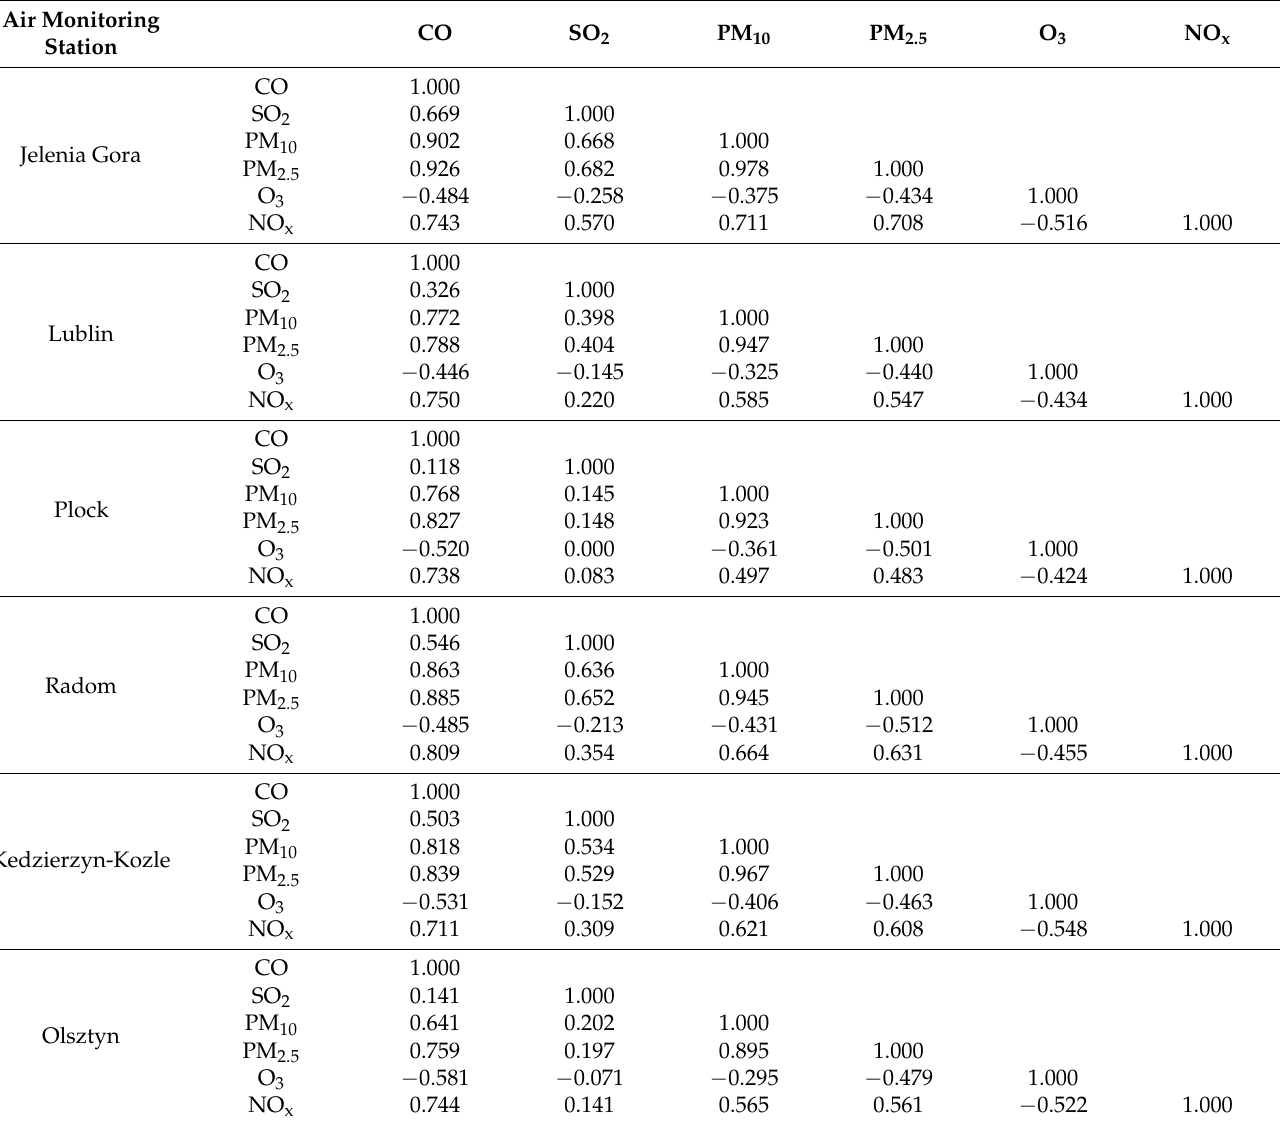
Table 4. Pearson’s correlation coefficient for variables registered at the air monitoring stations,